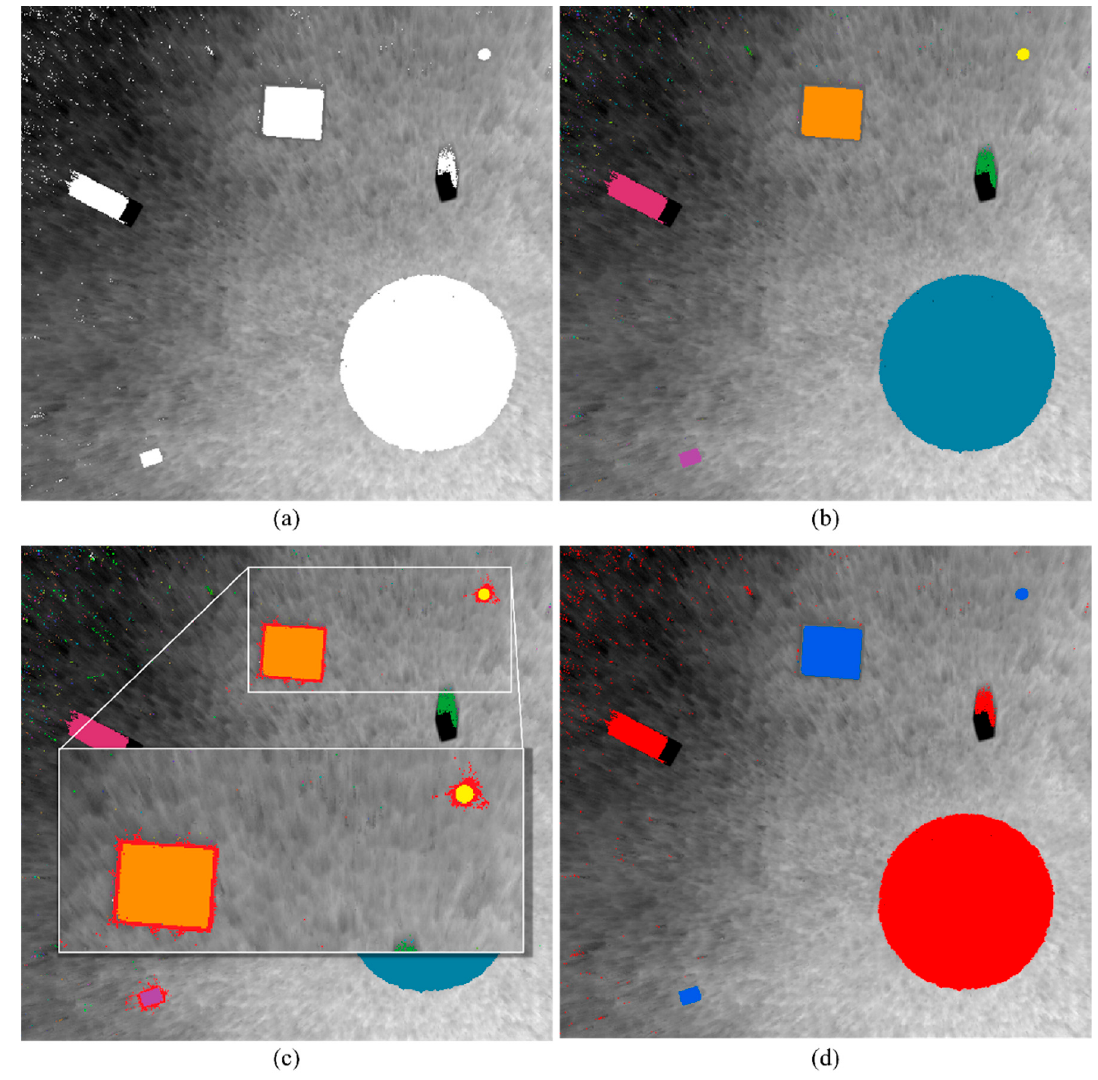
Figure 6. Demonstration of the TLS digital elevation model (DEM) data gap classification methodology. The DEM is colored with a grayscale color ramp (black is higher elevation). ( a ) Unclassified data gaps in DEM identified in white. ( b ) Individual data gaps are assigned unique identification number (ID). Each unclassified data gap is assigned a unique random color for visualization purposes. ( c ) The dropout boundary flag raster (red pixels surrounding some of the data gaps) is introduced. ( d ) The dropout boundary raster is used to classify data gaps as either occlusions (red) or dropouts (blue).